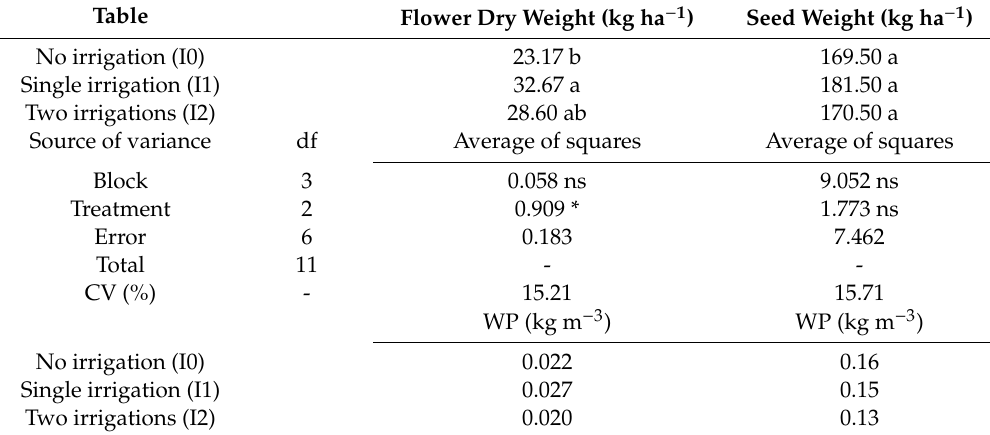
Table 4. European borage productivity and ANOVA results in 2013. Table